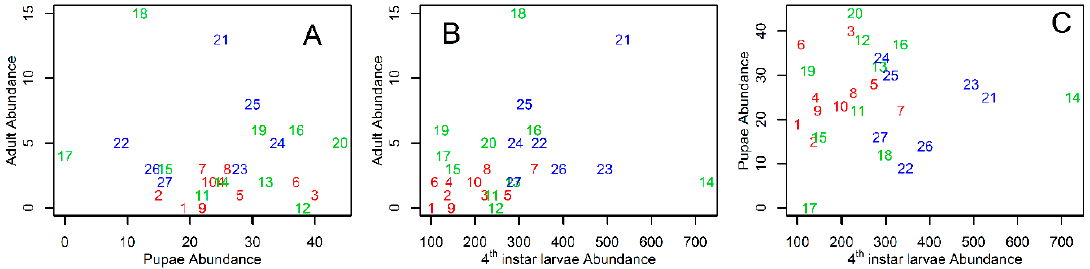
Figure 6. Abundance association among Tripteroides bambusa stages at Mt Konpira, Nagasaki, Japan. Adult abundance as function of ( A ) pupae abundance and ( B ) fourth instar larvae abundance. Pupae abundance as function of ( C ) fourth instar larvae abundance. In all plots, numbers and colors represent, respectively, the sampling locations and transects described in Figure 2.